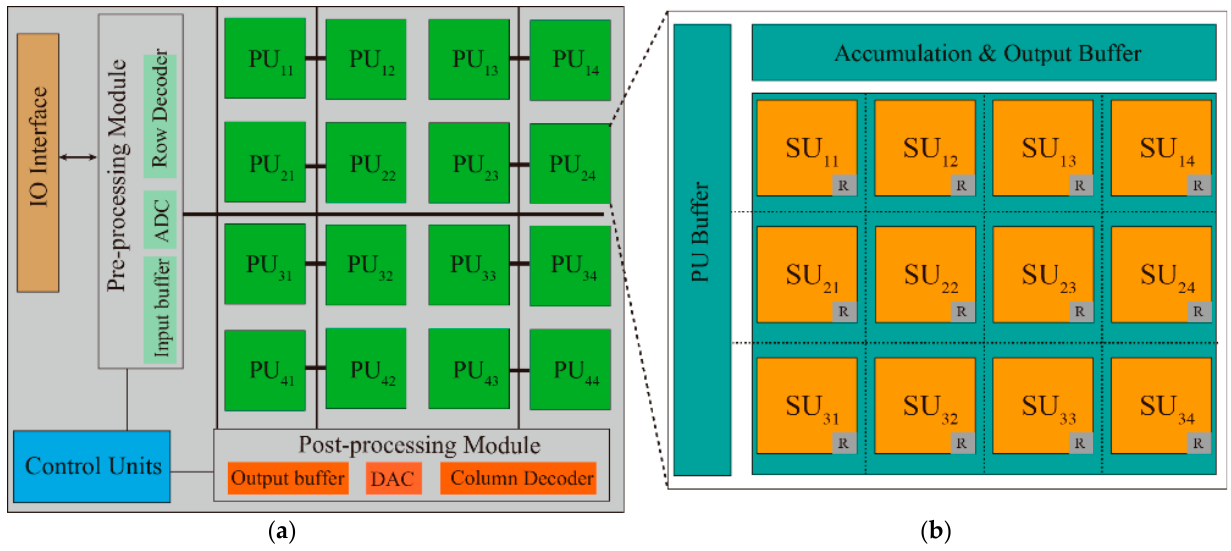
Figure 5. ( a ) The diagram of skyrmion-based SNN architecture contains 16 PUs. ( b ) Each PU contains 12 SUs and other peripheral circuits.